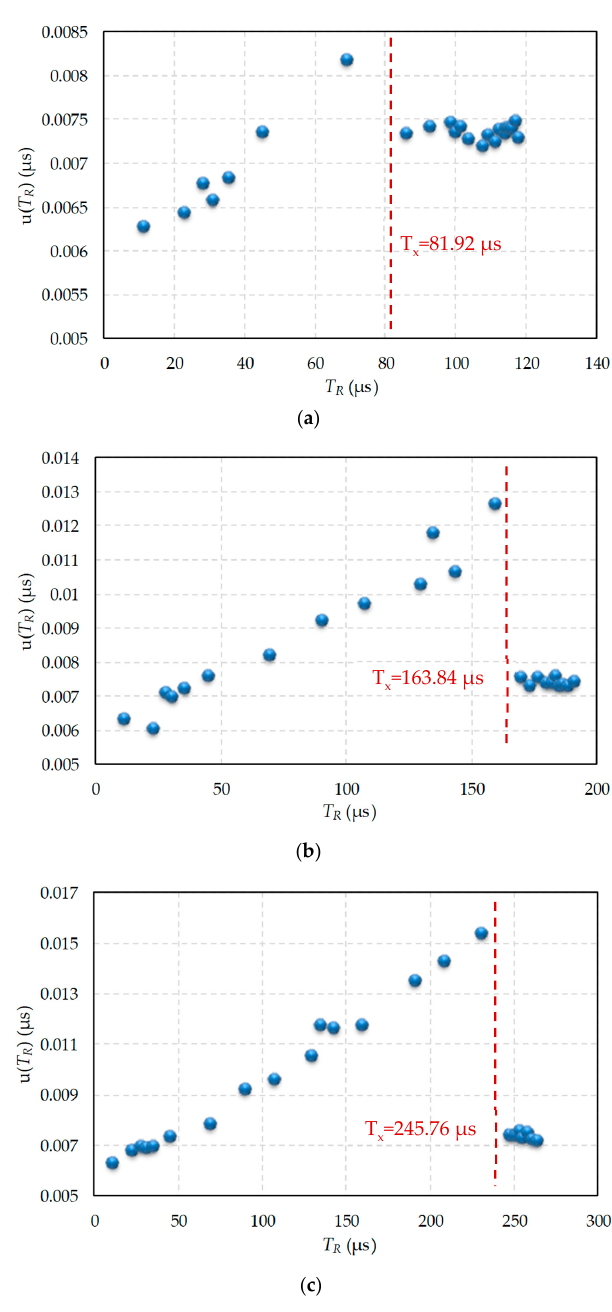
Figure 5. Uncertainty in the discharge time measurement when R intervenes, and the modified discharge procedure is applied. ( a ) T x = 81.92 µs, ( b ) T x = 163.84 µs, ( c ) T x = 245.76 µs.